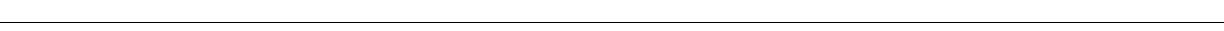
Fig. 6 LIMB approach reveals kinetics of vascular remodeling during bone healing and homeostasis on time scales from hours to months. C57/B6J mice received the LIMB implant and were injected intravenously with Qdots (red) prior to each LIMB imaging session to label the vasculature. Vessels were three-dimensionally imaged at increasing time resolution over the course of a weeks b days and c several hours. In line with our previous observations, we noted prominent changes in the vasculature, which continued over the whole monitoring time period, even after homeostasis is reached ( n = 5 mice, two independent experiments, scale bar = 50 µ m). Small vessels continuously appear and disappear, larger vessels change their position and shape. The trace of such a larger vessel is displayed at all time points as a line in c . Blood vessels which can be used as landmarks are labeled by arrowheads and those that completely disappear within days are labeled by asterisks. d Overlap of the 3D projections of blood vessels in a mouse 35 days post-surgery (+0 h, green) and 24 h later (+24 h, red). A differential image between the two 3D images was generated. Blood vessel volume change was calculated by dividing the fraction of the volume difference between +24 h and 0 h (cyan areas in the middle panel indicate positive values, i.e., appearance of blood vessels; yellow areas indicate negative values, i.e., disappearance of blood vessels) by the total volume of the blood vessel at +24h (delineated by white lines in the left panel) to obtain a normalized parameter of vessel volume change. The normalized volume changes (right panel) are dependent on the blood vessel diameter, with small vessels remodeling more rapidly than large vessels ( n = 6 mice, scale bar = 100 µ m). e Similar to the observations in the deep